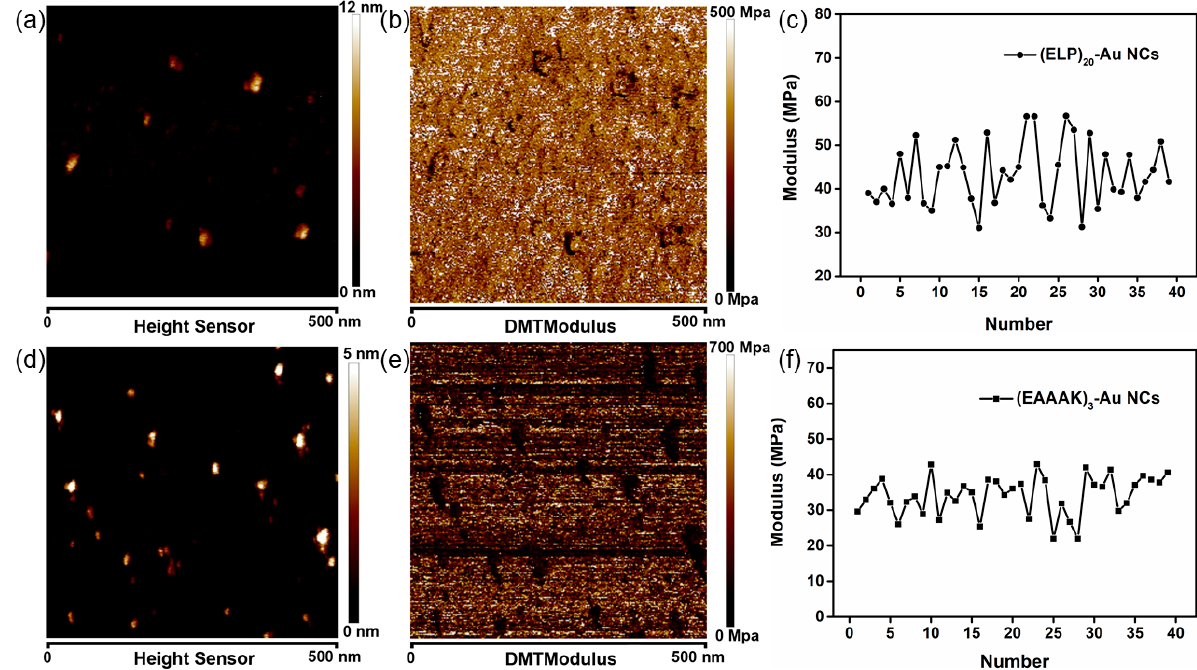
Figure 5. AFM imaging and Young’s modulus measurement of the Au NCs. ( a ) AFM image ( b ) Young’s modulus measurement and ( c ) distribution of (ELP) 20 -Au NCs. ( d ) AFM image ( e ) Young’s modulus measurement and ( f ) distribution of (EAAAK) 3 -Au